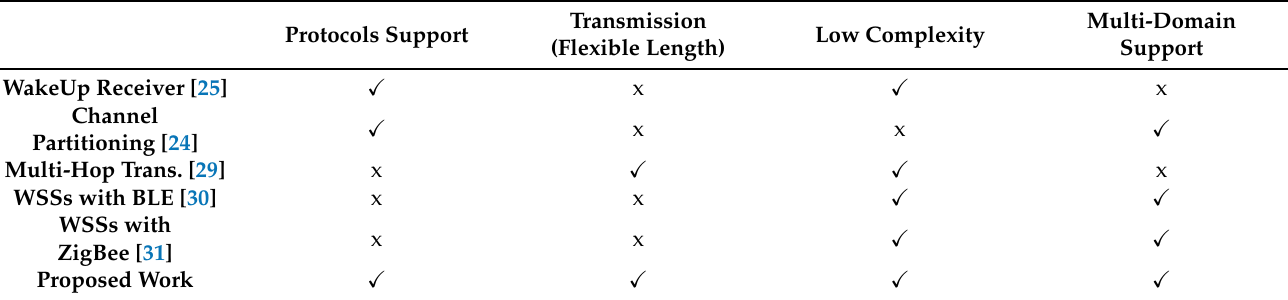
Table 6. Proposed approach compared to work in